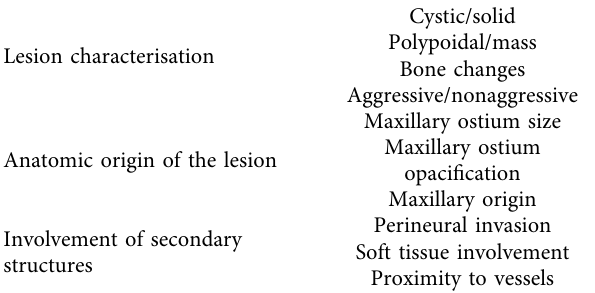
Table 1: 10-point diagnostic certainty